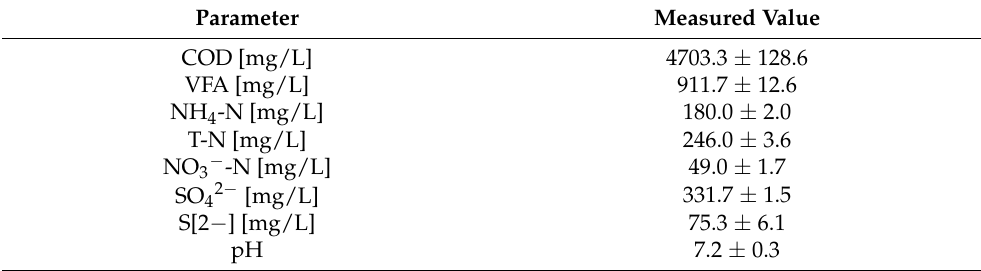
Table 2. Chemical characteristics of the industrial